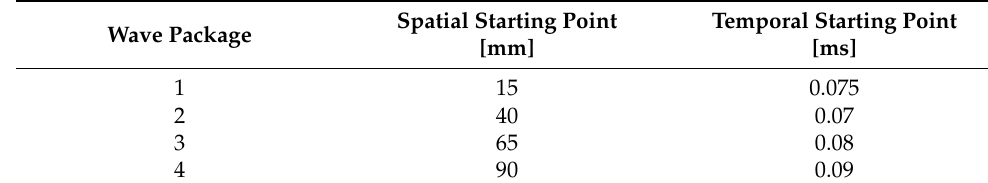
Table 4. Location of periodic wave reflections at 200kHz (cf. Figure 12a).